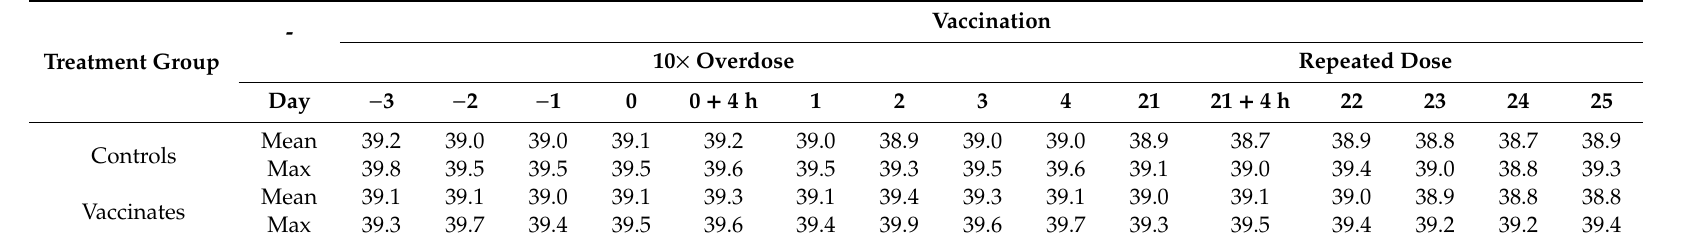
Table 2. Average body temperature ( ◦ C) in in Dutch Belted (DB) rabbits per day.